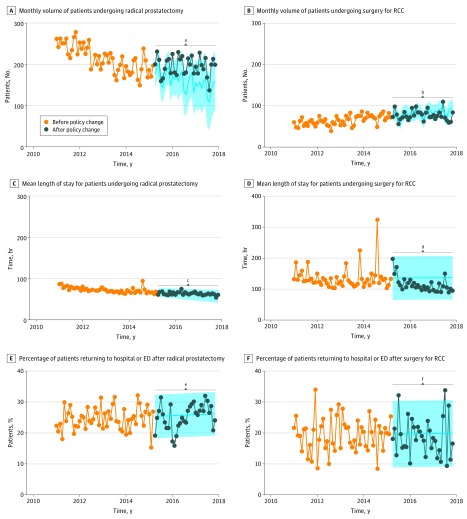
Monthly Volume, Mean Length of Stay, and Proportion of Patients Returning to the Hospital or Emergency Department (ED) Among 17 159 Patients Undergoing Radical Prostatectomy and 5762 Patients Undergoing Surgery for Renal Cell Carcinoma (RCC)The shaded areas represent the predicted 95% CIs, and the P values are based on a step function with a 0-order response.aP = .06.bP = .93.cP = .28.dP = .80.eP = .74.fP = .61.